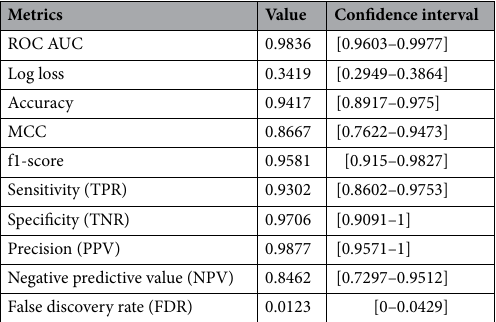
Table 1. A variety of metrics computed on the test sets. A threshold of 0.47 was used.